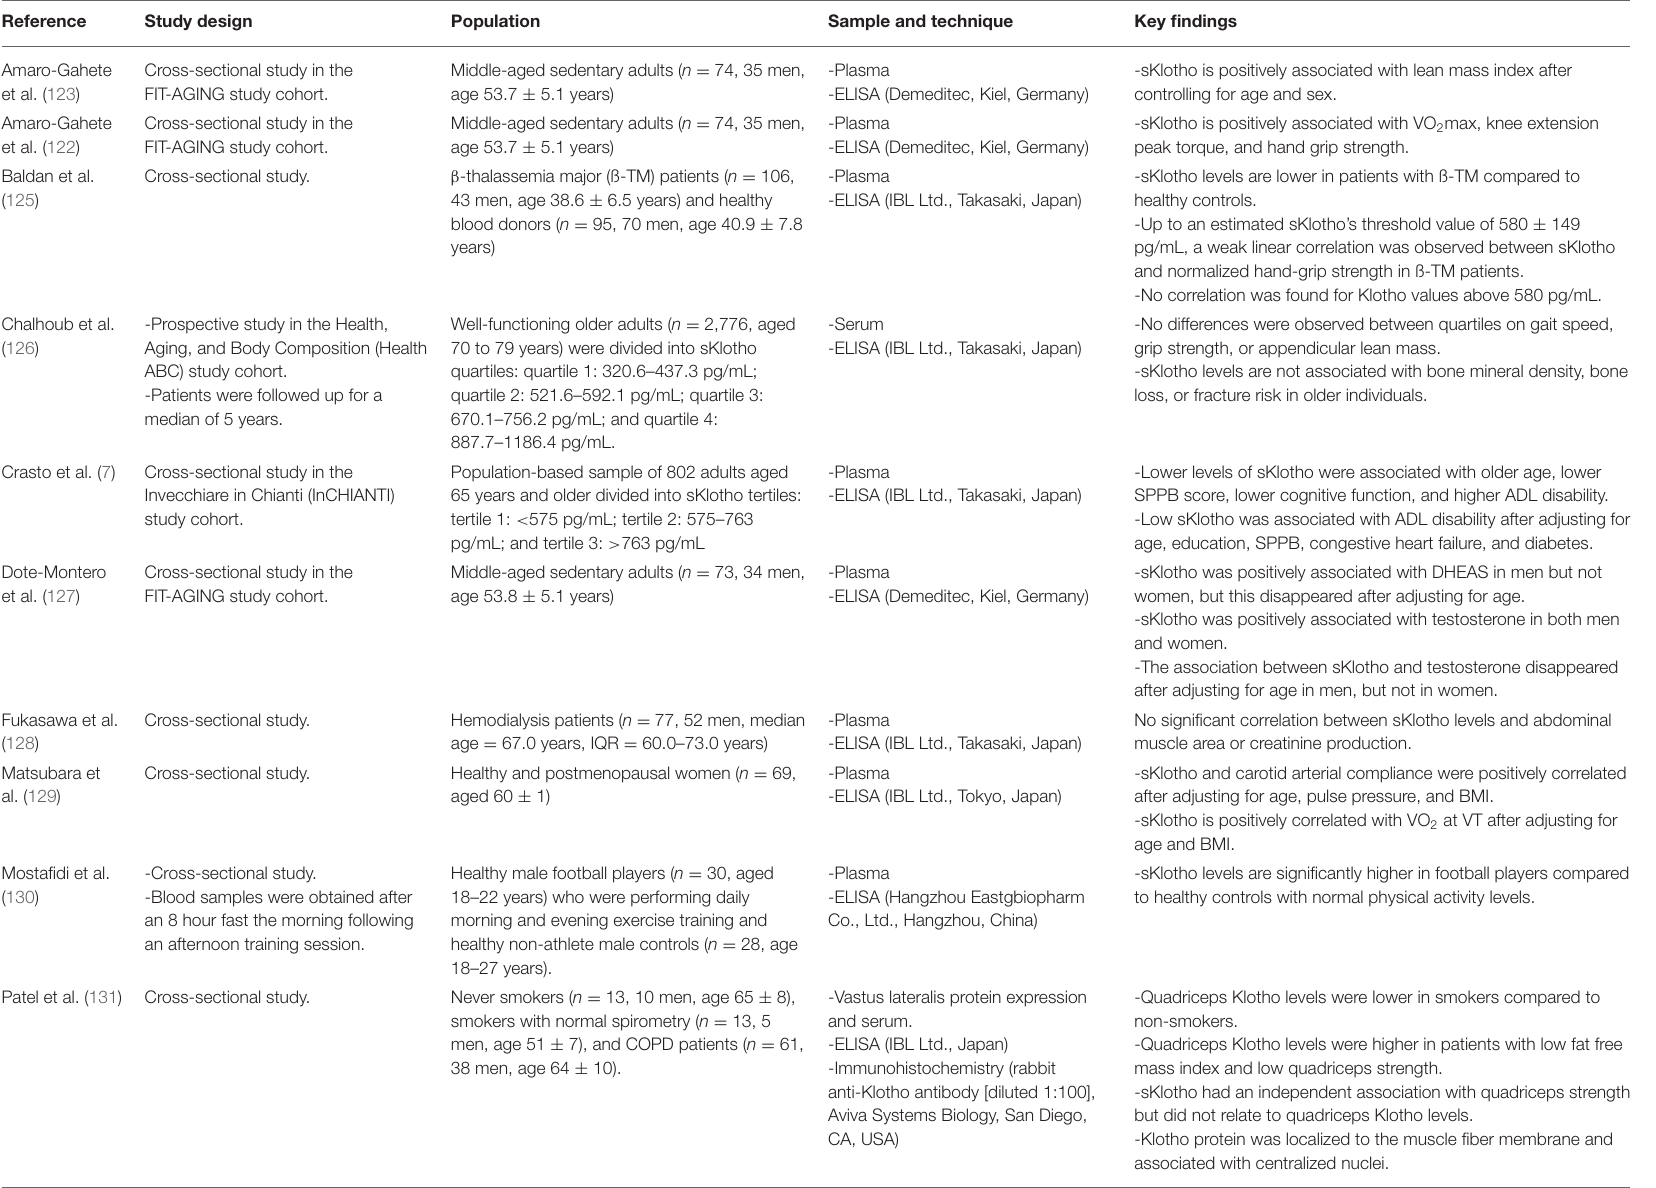
TABLE 1 | Relationship between Klotho levels and indices of physical function and